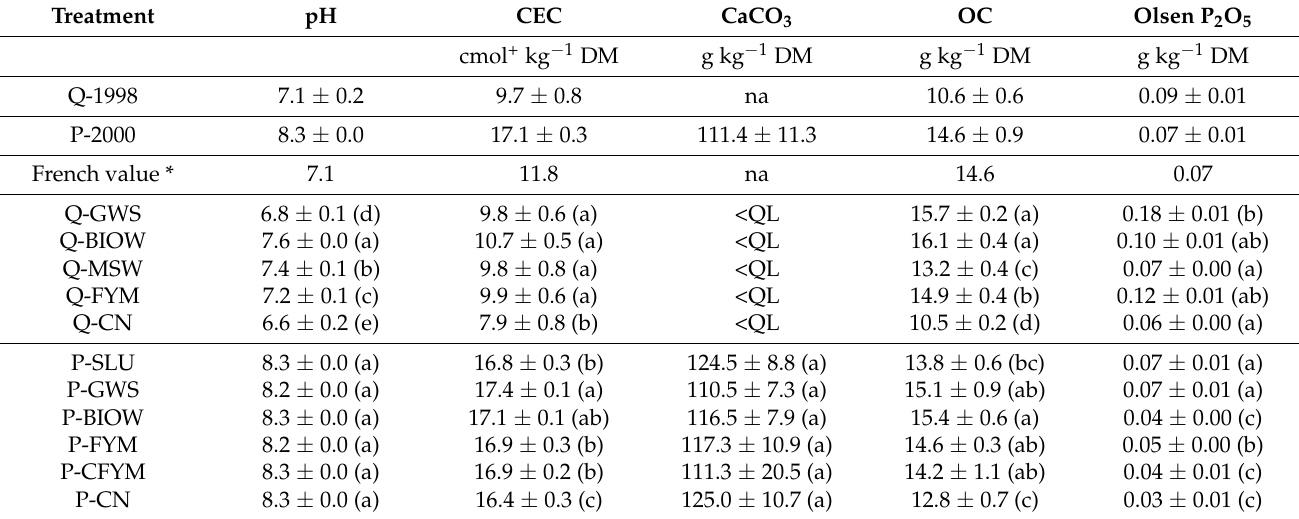
Table 4. Chemical properties of the topsoil layer (0–25 cm, sieved <2 mm) at the initial state and after 13 and 15 years of repeated OWP application, compared to average French values with the following data presented: pH, CaCO 3 and organic carbon (OC) content, content of Olsen phosphorus (Olsen P 2 O 5 ), DM for dry matter. At initial state with mean values ± standard deviations for all plots. After 13 and 15 years of repeated OWP application with mean values ± standard deviation of the four replicates (in each site, abc letters stand for significant difference between treatments with Newman– Keuls and Kruskal–Wallis tests). See Figures 1 and 2 for treatments signification. <QL values lower than the quantification limit. na for not